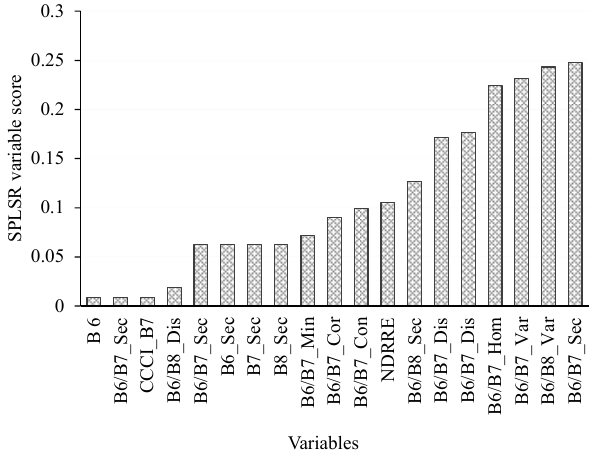
Figure 6. Best variables selected using SPLSR, in estimating above-ground grass biomass across different grassland management treatments. Note that on ‘B6/B7’ represents the ratio of WV-3 Bands 6 and 7 and NDRE is the normalized difference red-edge index.